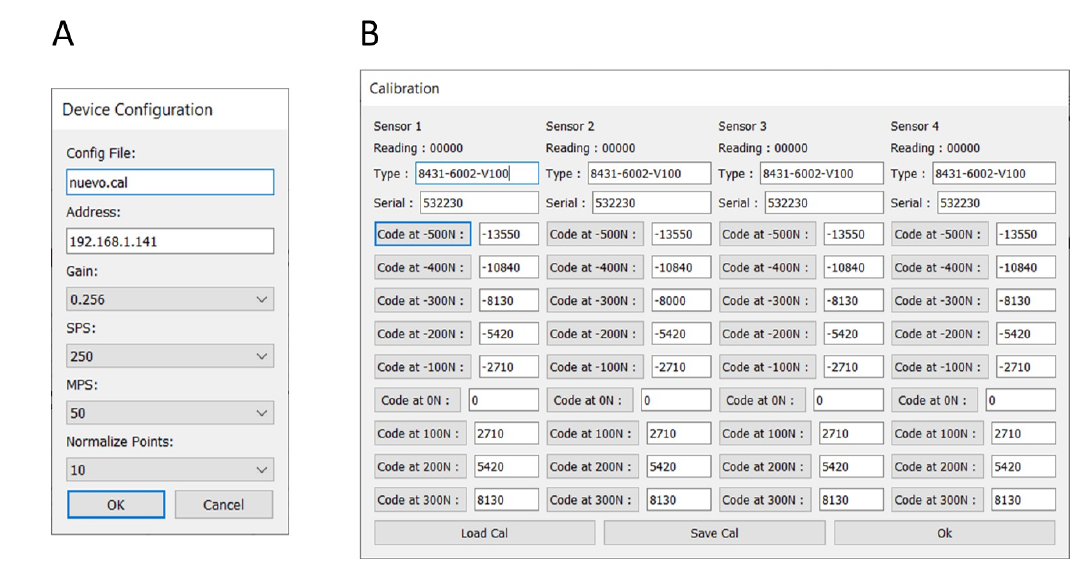
Figure A2. ( A ) GUI Config. option. ( B ) GUI manual calibration